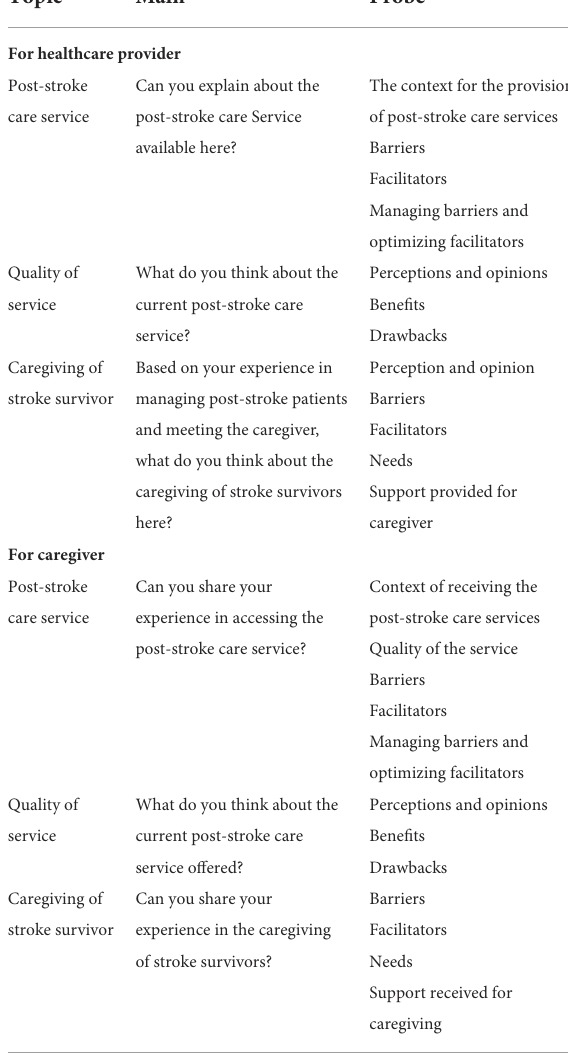
TABLE 1 Topic guide for in-depth